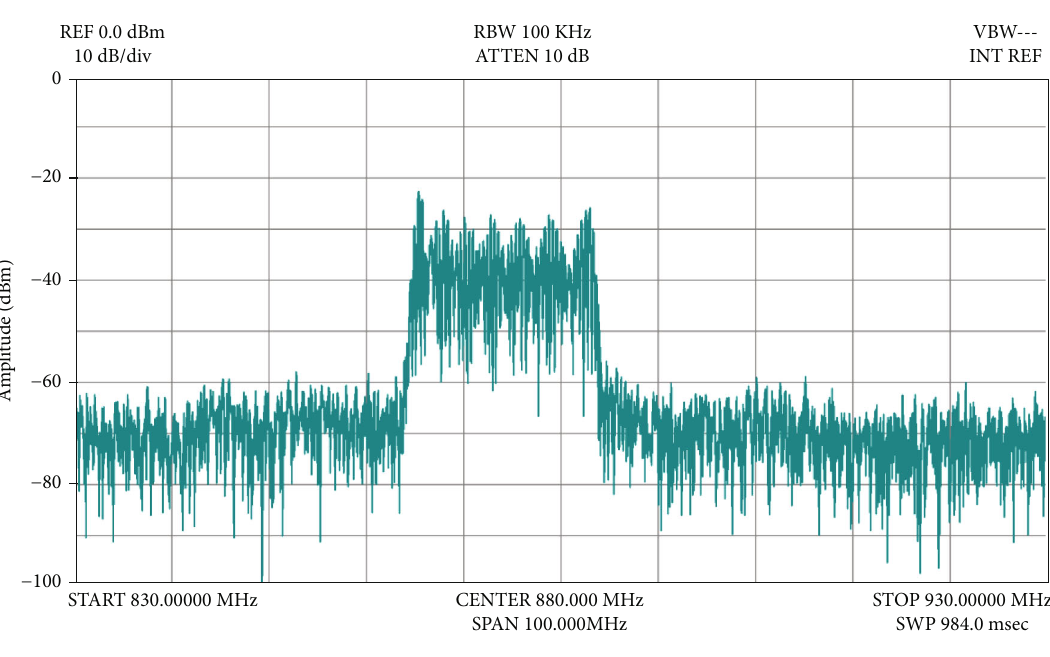
Figure 2: Spectrum of CDMA